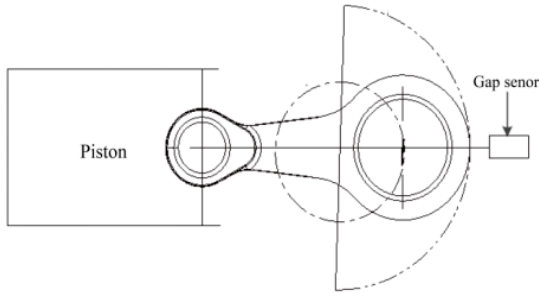
Figure 7. Explanation for the measure of the crank angle.